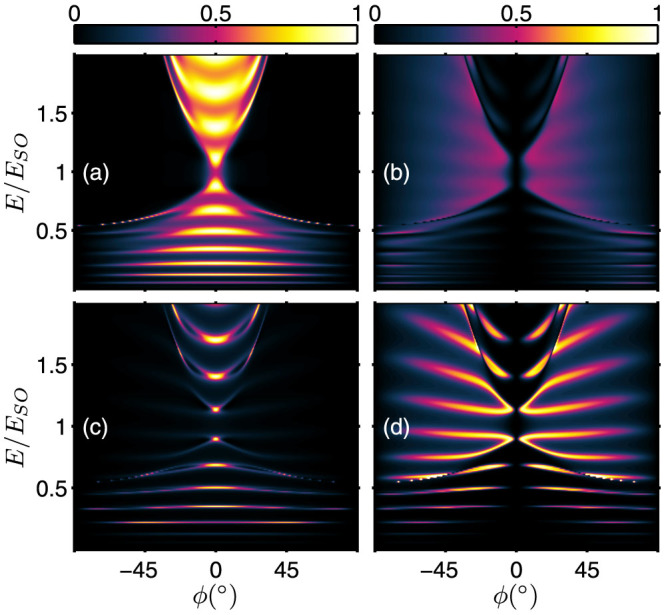
Energy spectrum of the transmission probabilities in the presence of symmetrical interface scattering potential ZL = ZR.ZL = ZR = 0.5: (a) ; (b) ; and ZL = ZR = 1.5: (c) ; and (d) . The tunneling junction parameters are d = 20 nm, V0 = ESO and kSO = 1.3 × 109 m−1.